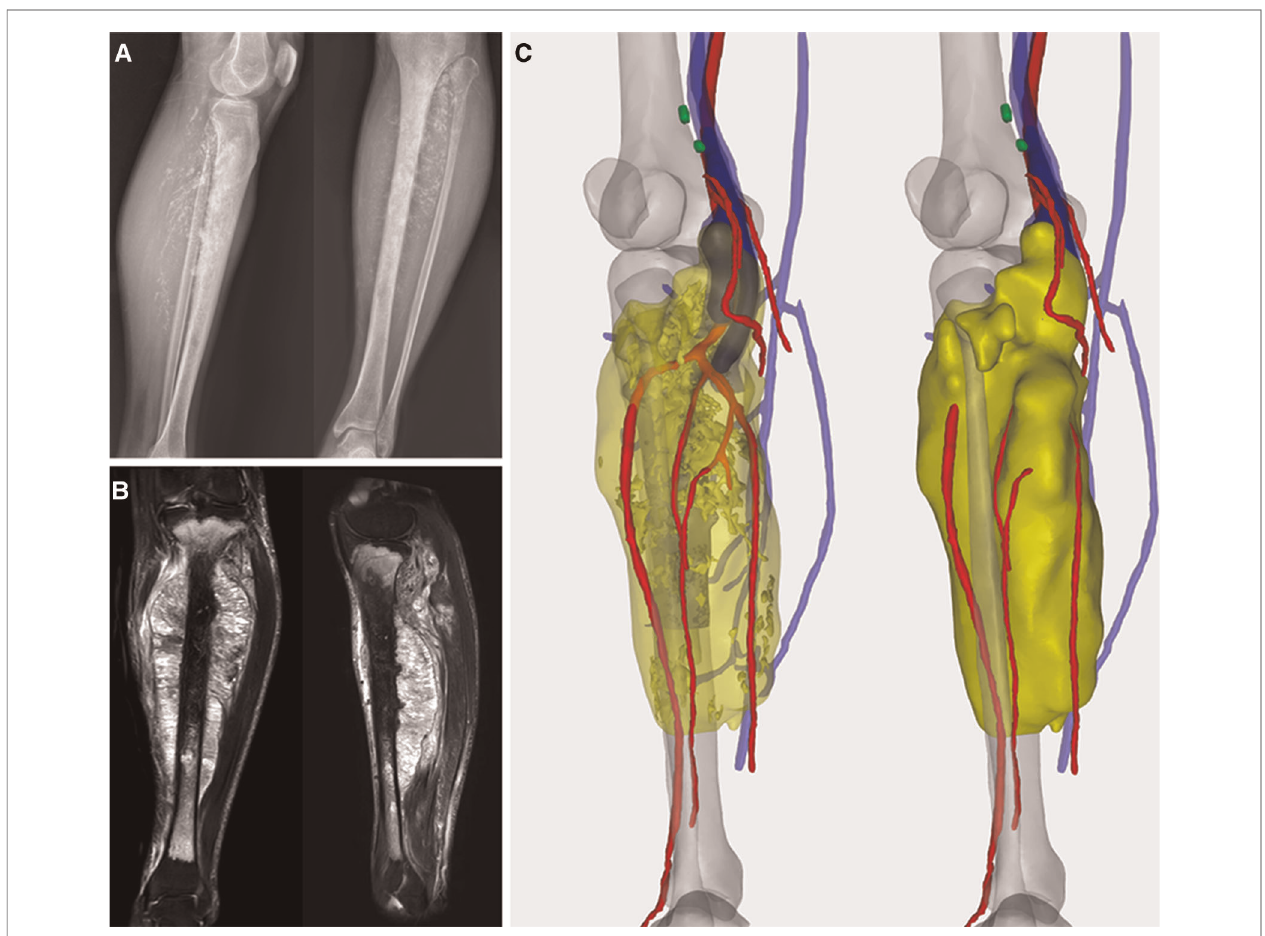
FIGURE 1 | ( A ) Preoperative X-ray indicated the spindle-shaped lesion; ( B ) preoperative MRI showed tumor involving the whole length of the tibia with a heterogeneous hyperintense signal on T1-weighted and hypointense signal on T2-weighted images. ( C ) Computer-aided, 3D angiography illustrated the anterior tibial artery, posterior tibial artery, peroneal artery, and vena comitans of the affected side were